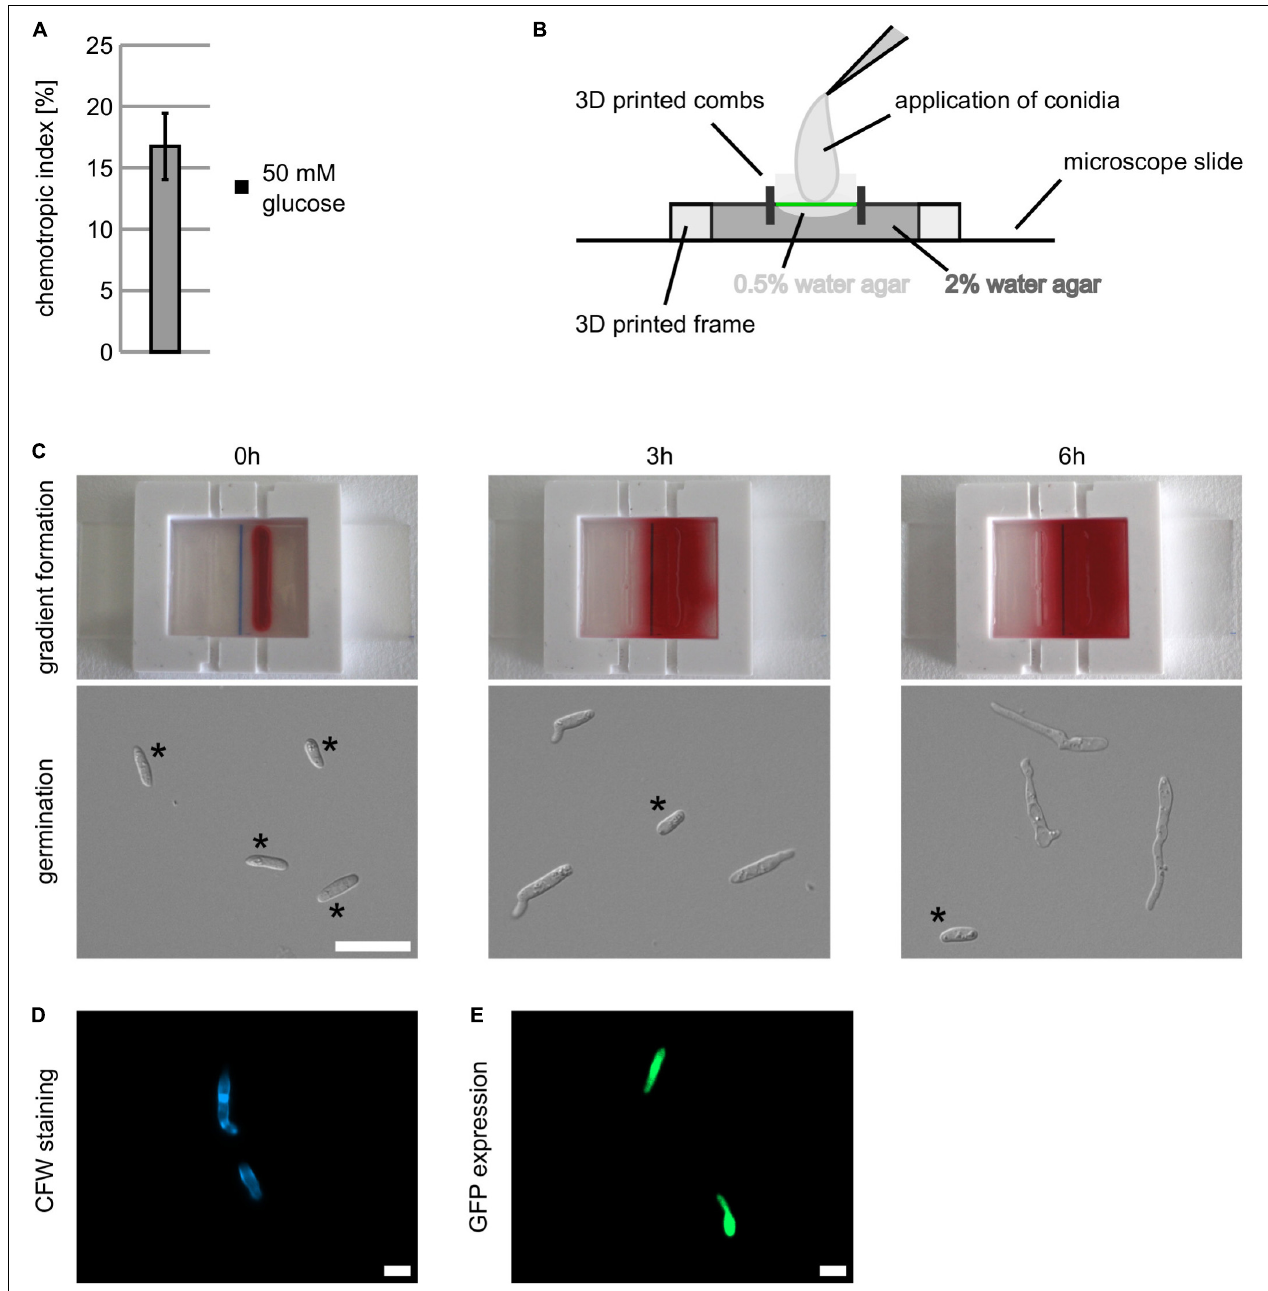
FIGURE 2 | Establishment of an operation mode to measure chemotropic growth responses using the new generated 3D printed device. (A) Chemotropic growth of C. graminicola oval conidia to a gradient of 50 mM of glucose quantified with the chemotropic plate assay, error bars represent SD calculated from n = 5 experiments as indicated. (B) Arrangement of 3D printed frame and 3D printed combs on an microscopic slide. 2% of water agar [1% (w/v) agarose, 1% (w/v) agar (Serva)] is fixing the device on the microscope slide (dark gray). Due to surface tension, a concave surface forms in between the created wells. To even the surface (green line), 0.5% of water agar [0.25% (w/v) agarose, 0.25% (w/v) agar (Serva)] are applied (light gray). (C) Depiction of gradient buildup over time by spread of Ponceau stain and respective germination of C. graminicola oval conidia. Conidia not germinated are indicated*. (D,E) Visualization of C. graminicola germlings stained with 1:1 diluted calcofluor white (CFW, D ) and expressing cytosolic GFP (E) after incubation in the 3D printed device for 6 h, size bar = 10 µ m.